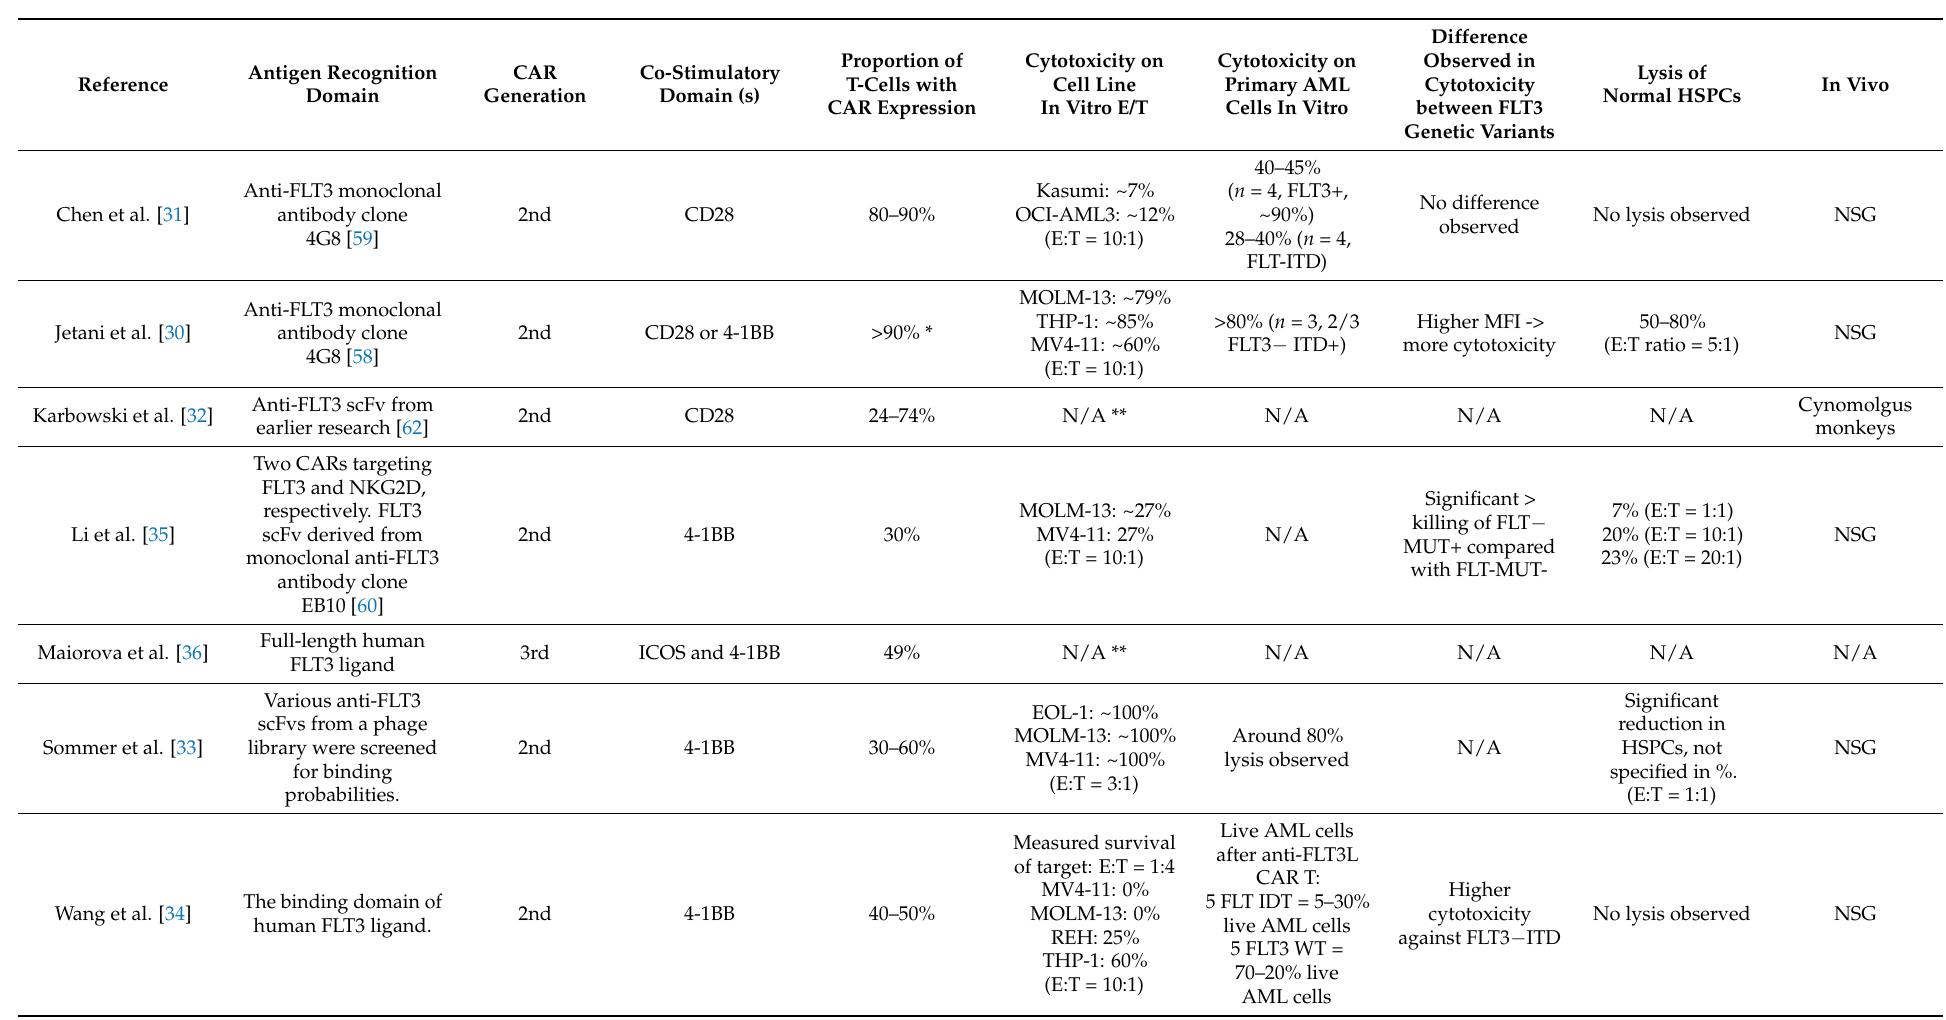
Table 1. Overview of anti-FLT3 CAR T-cells derived from text or figures of the referenced